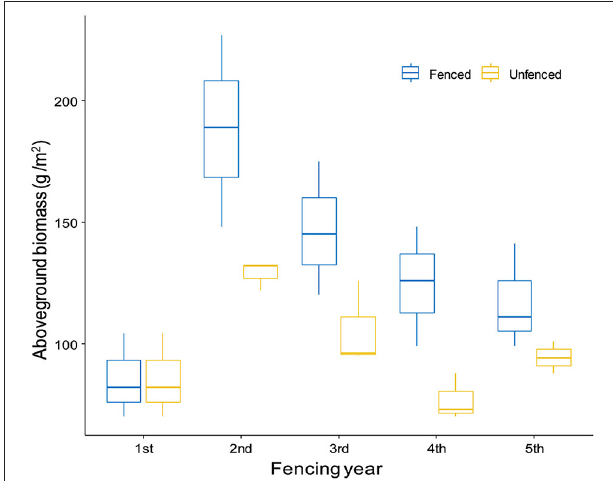
FIGURE 5 | Fence effects on aboveground biomass across 5 years in the mountain steppe, Tuvshruulekh monitoring station in Arkhangai province (redrawn based on the data from Banzragch and Chognii, 1975). Three subsites under different grazing intensity levels were considered as repeated measurements